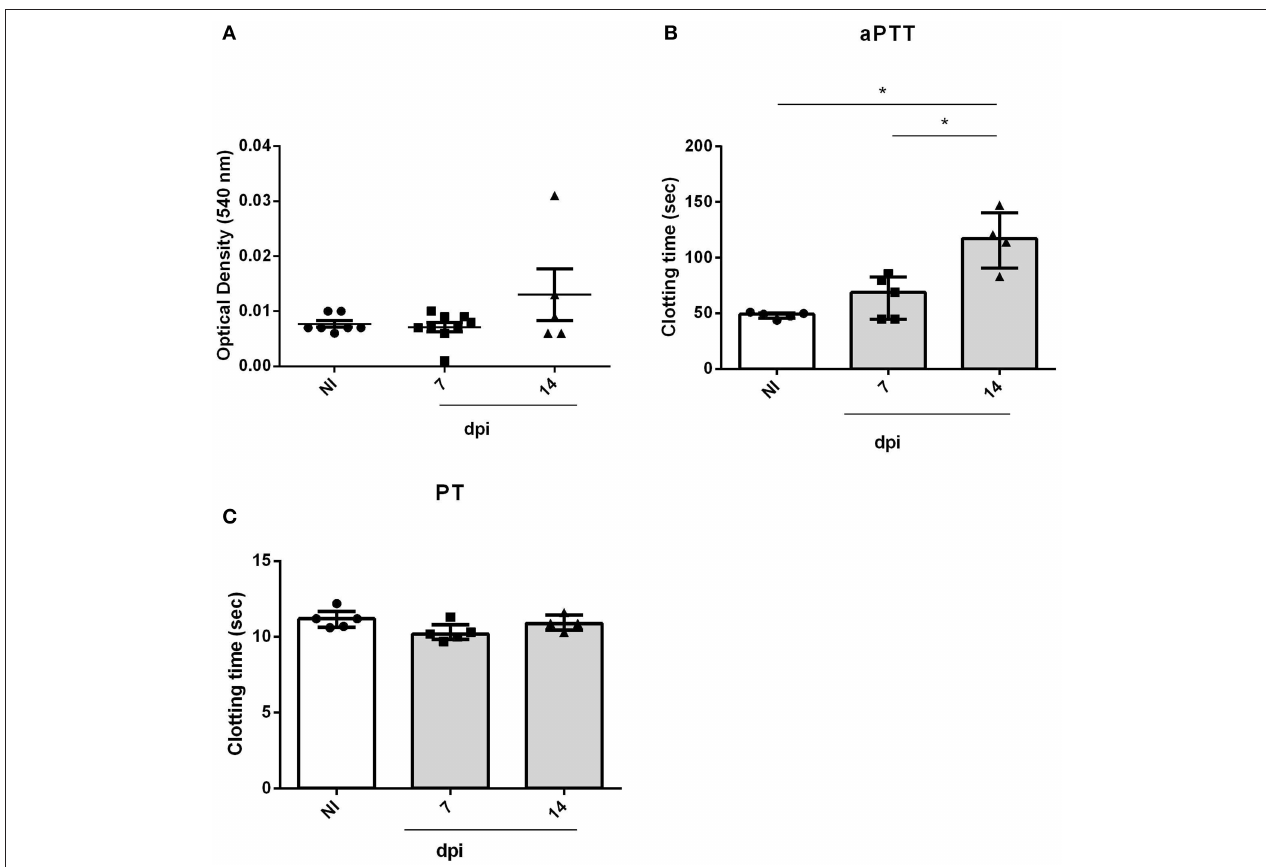
FIGURE 5 | Bleeding from the tail and ex vivo PT and aPTT measurements of BALB/c mice during subcutaneous infection. Male BALB/c mice were subcutaneously infected with 5 × 10 4 culture-derived T. cruzi trypomastigotes (Tulahuén strain). (A) Bleeding was caused by a tail transection in NI, 7 and 14 dpi SC mice. Absorbance at 540nm (hemoglobin concentration) was used to estimate blood loss. (B,C) NI or SC plasma samples were obtained by cardiac puncture followed by addition of aPTT or PT reagent. Clotting time was estimated using a coagulometer. (A-C) Values are presented as mean ± SEM for each group/day post-infection and are representative of one experiment. Results were analyzed using one way ANOVA with Tukey’s multiple comparisons test (*0.0001 < p <